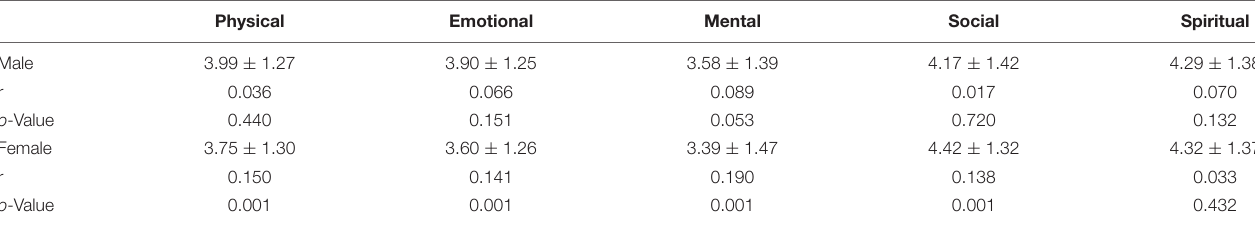
Physical Emotional Mental Social